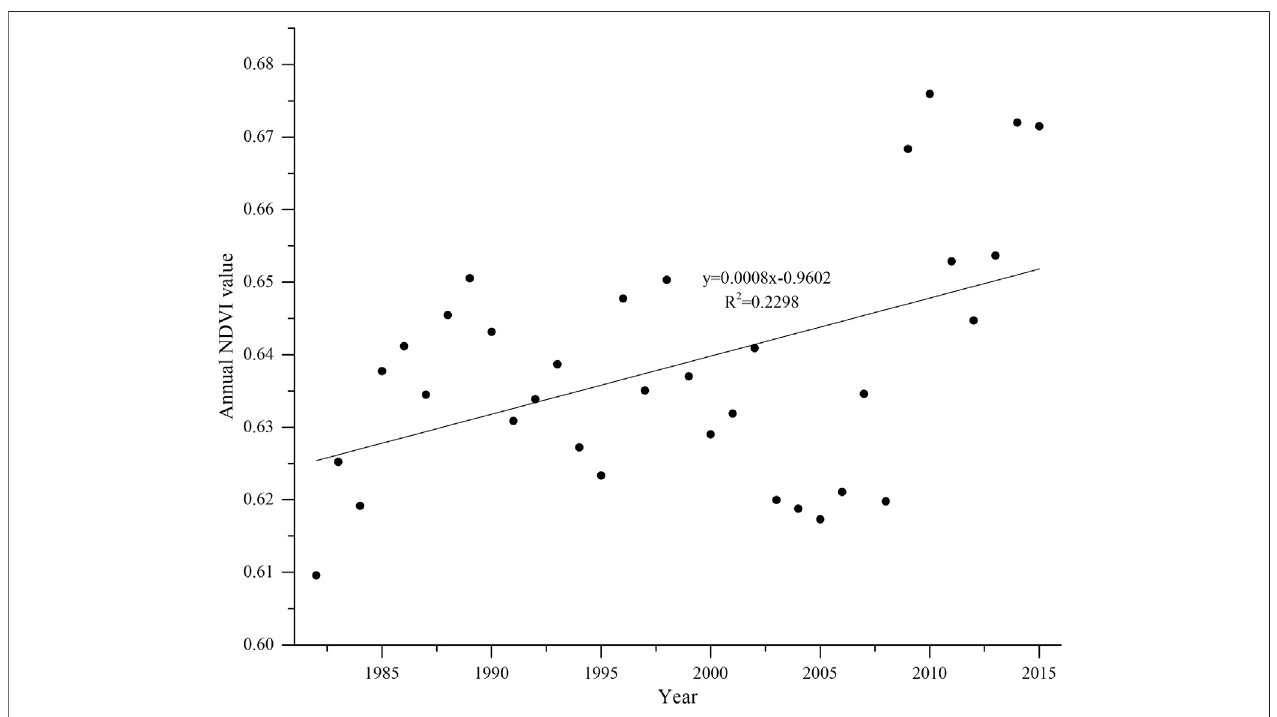
FIGURE 6 | Change trend of annual NDVI in the Huangshui River basin from 1982 to 2015.